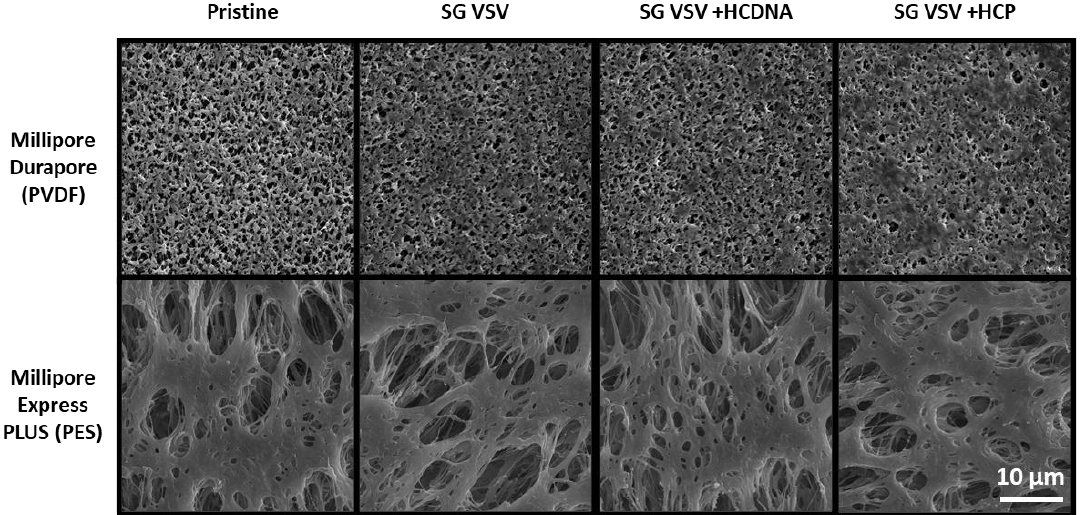
Figure 5. Scanning electron microscopy images (at 5000× magnification) of Durapore PVDF 0.22 µm and Express PLUS PES 0.22 µm membranes either in pristine (unused) condition or after filtering sucrose-gradient-purified vesicular stomatitis virus (SG VSV) with added host cell DNA (HCDNA) or host cell protein (HCP).